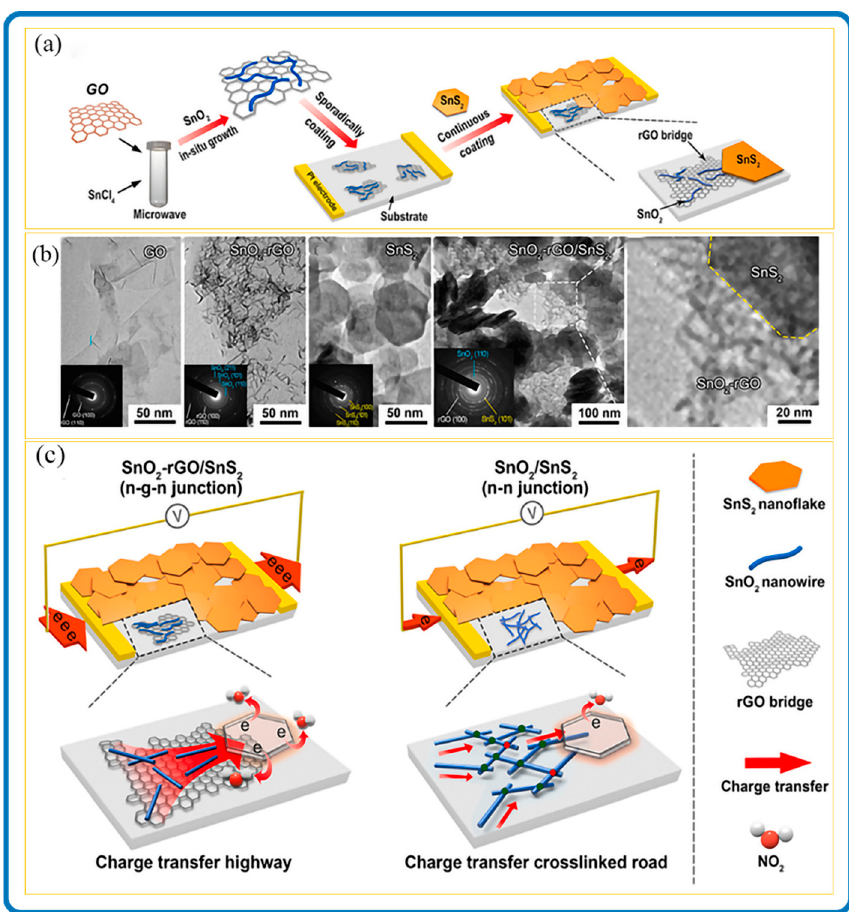
Figure 11. ( a ) Schematic diagram of the construction of ternary SnO 2 -rGO/SnS 2 gas sensor with n-g-n junctions. ( b ) Subsequent TEM images. ( c ) Schematic images of charge transfer modification between SnO 2 -rGO/SnS 2 sensor with novel n-g-n heterojunctions and SnO 2 /SnS 2 sensor with traditional n-n junctions. Reproduced with permission from [104]. Copyright 2021, Elsevier.